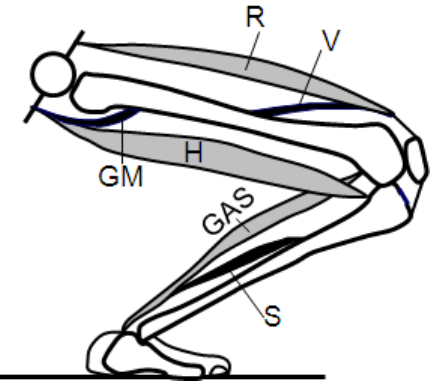
Fig.2 Illustration of the muscles included in the model. They are the gluteal muscles (GM); quadriceps(Q), including rectus femoris (R) and the vasti (V); hamstrings (H), and calf muscles, including the gastrocnemius (GAS) and soleus (S). Hereafter the same symbols in Italic will be the equation variables representing the forces exerted by the respective muscles, thus GM stands for the forces exerted by GM and so on.